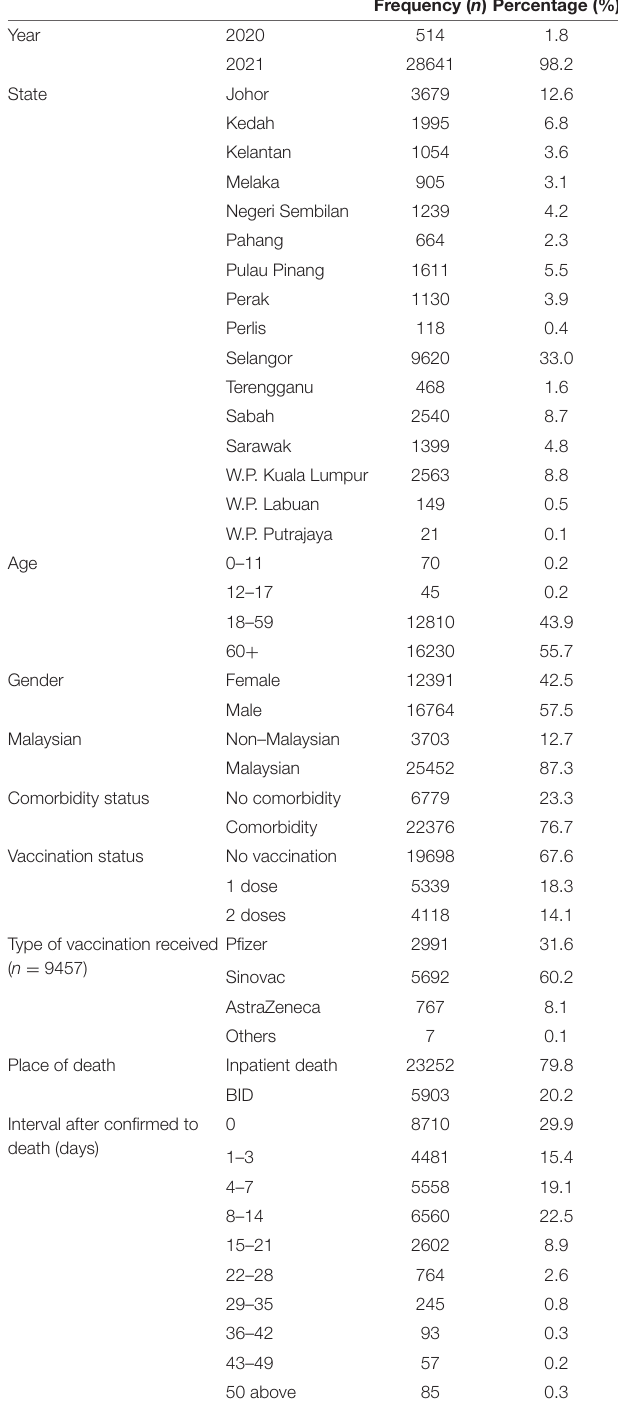
TABLE 1 | Distribution of the COVID-19 mortality cases ( N =